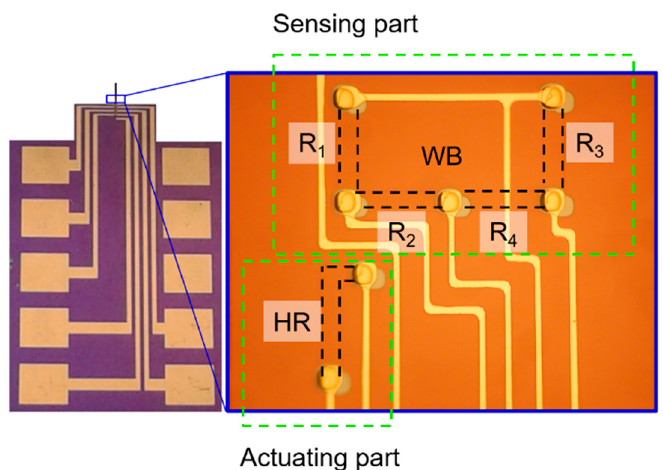
Figure 2. Optical micrograph of the electro-thermal piezoresistive cantilever sensor top surface showing the heating resistor (HR, actuating part) and the U-shaped Wheatstone bridge (WB) with resistors R i (i = 1,2,3,4) representing the sensing part.